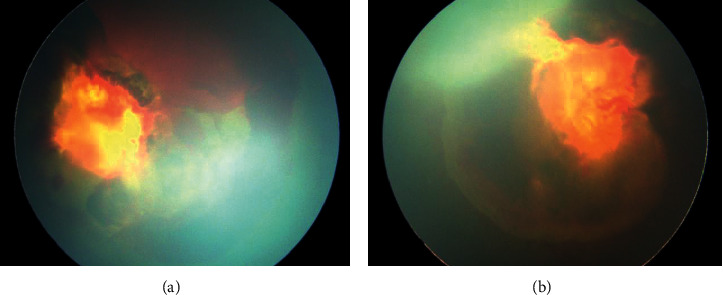
Colour fundus of case 5. (a) Right eye. (b) Left eye. Both eyes showed total retinal detachment with fibrosis and haemorrhage in front of the optic nerve.